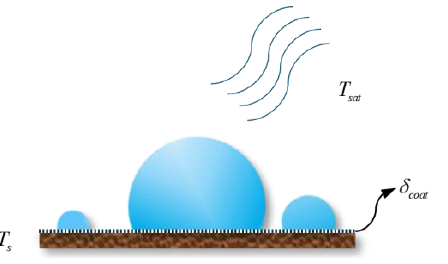
Figure 2. Thermal resistance model of droplet condensation growth.